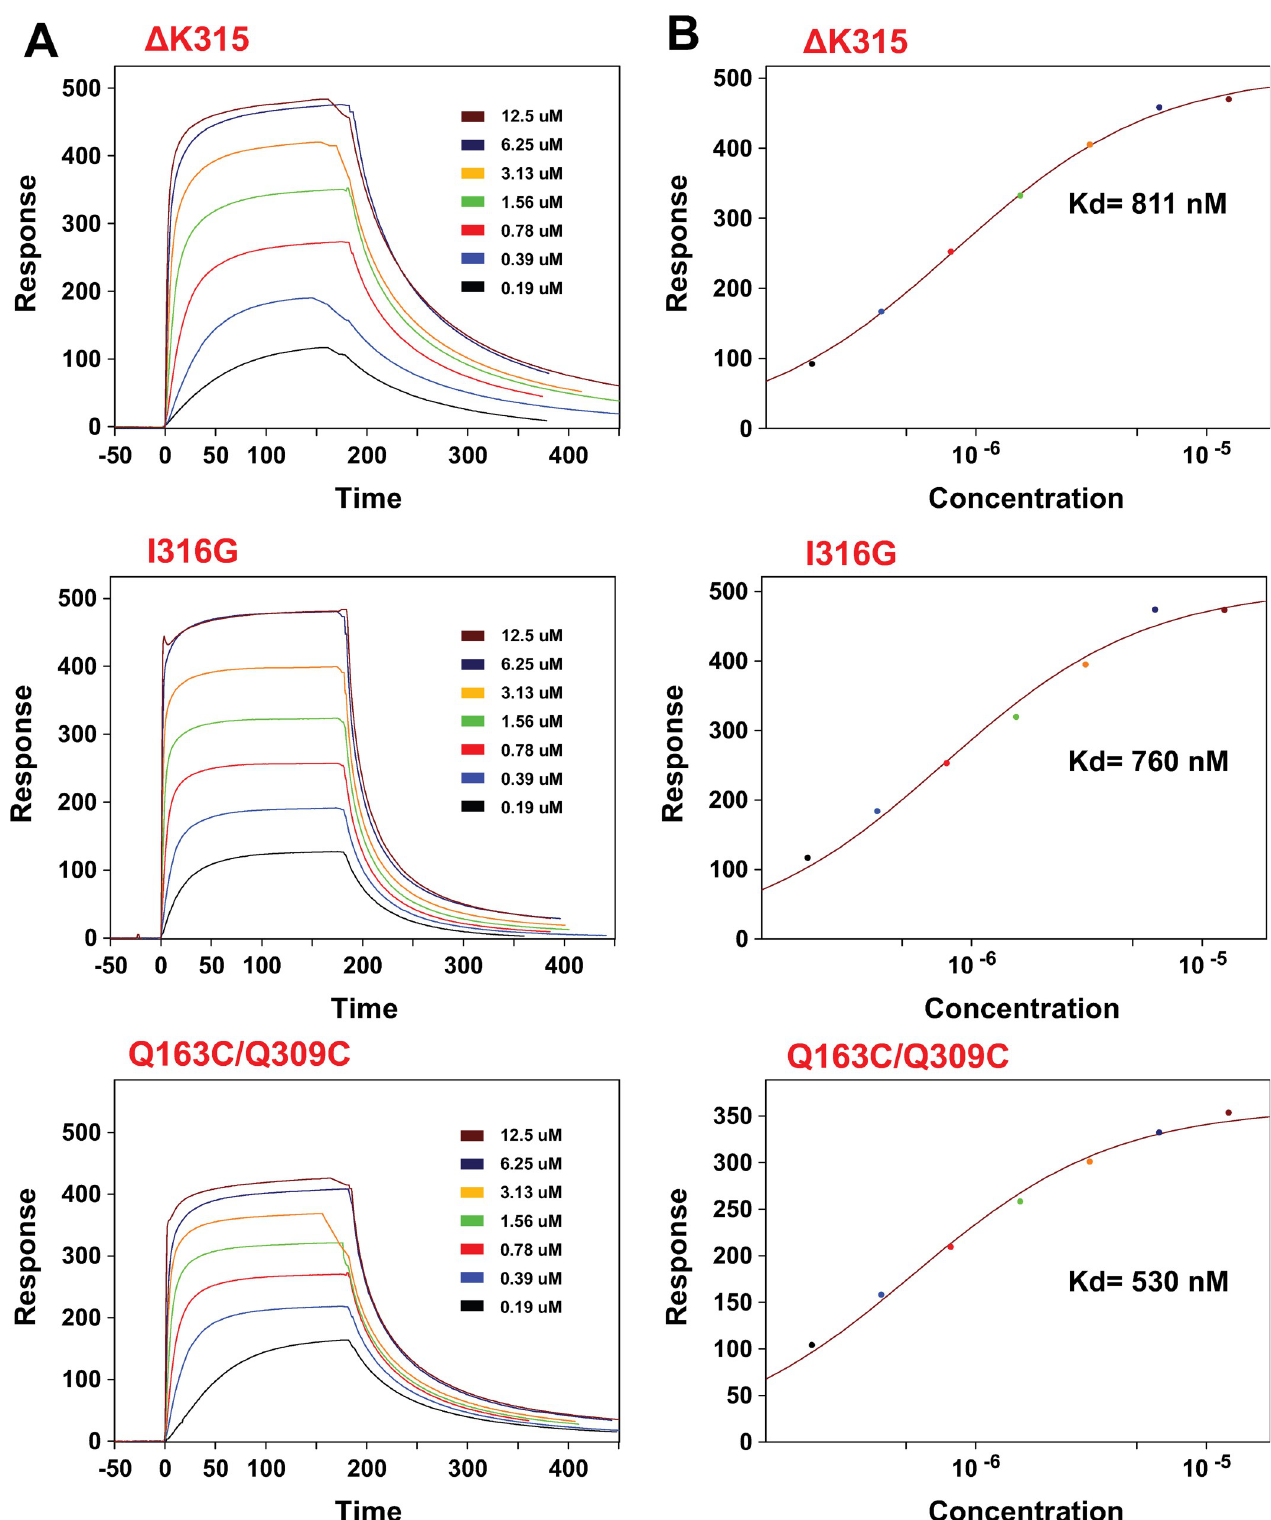
Fig 3. SPR characterization of C3d’s interactions with active α M I-domains. A) sensorgrams of a C3d-functionalized sensor treated with 0.19, 0.39 0.78, 1.56, 3.13, 6.25, and 12.5 μ M of Δ K315, I316G, or Q163C/Q309C mutants. Injection of α M I-domain started at time zero and ended after 180 seconds. B)